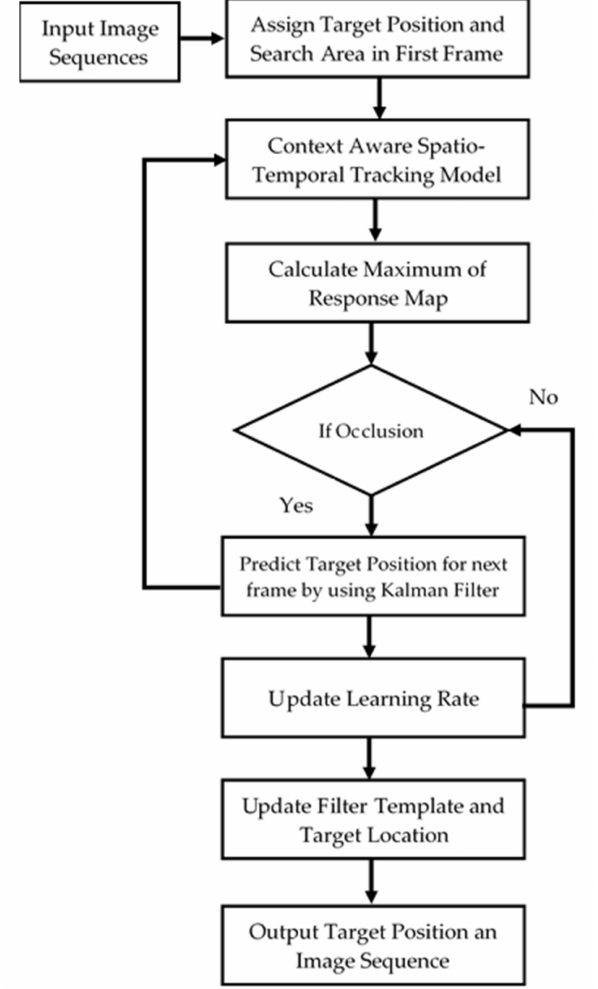
Figure 2. Implementation process of context-aware formulation, spatio-temporal context, adaptive learning rate and Kalman filtering in the tracking